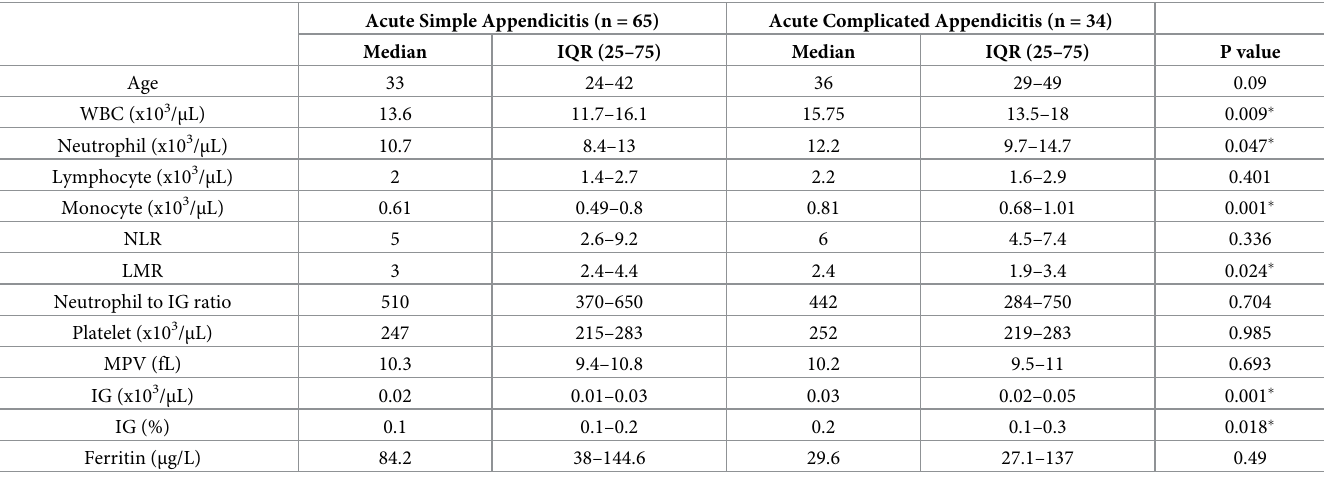
Table 2. Biochemical variables of control and acute appendicitis